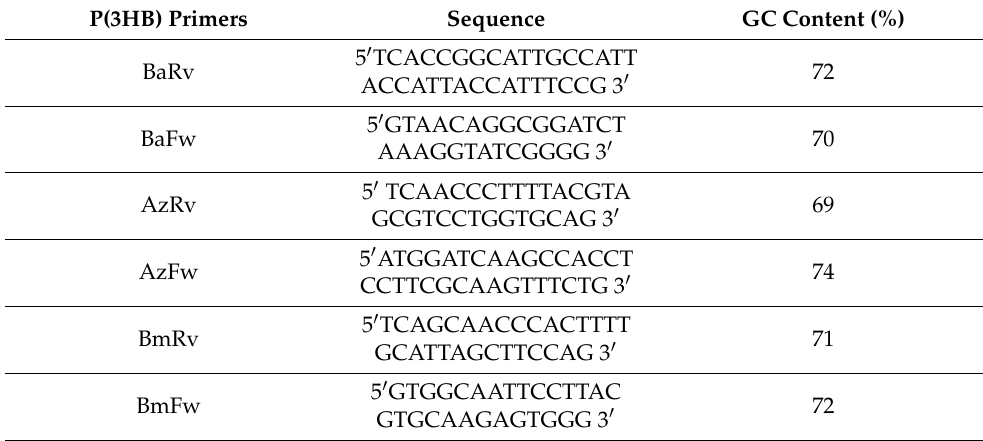
Table 1. Sequence of primers used for specific amplification of the phbC and phbB gene fragment. P(3HB)